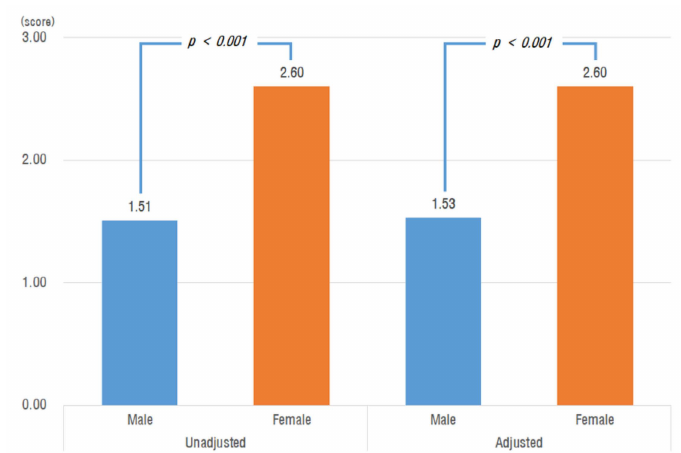
Figure 1. Kaigo-Yobo score by sex; p -value from t -test; Adjusted for age, sex, spouse, subjective economy, hypertension, diabetes mellitus, sarcopenia, osteoporosis, RKOA, Hb, total cholesterol, albumin, and 25(OH) vitamin D.